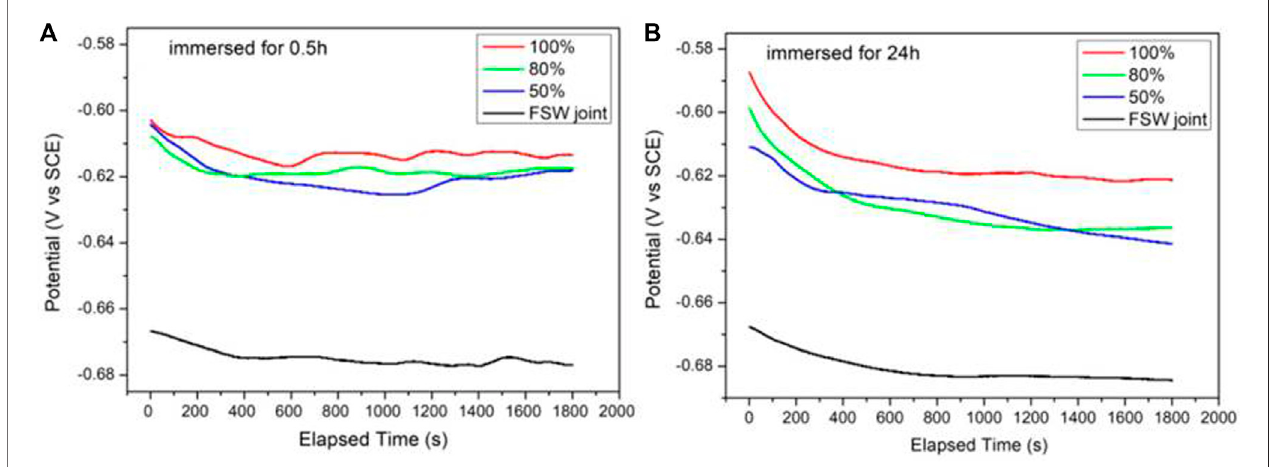
FIGURE 6 | Changes of the OCPs for FSW joint and Ni coatings immersed for 0.5 h (A) and 24 h (B) in simulated seawater.